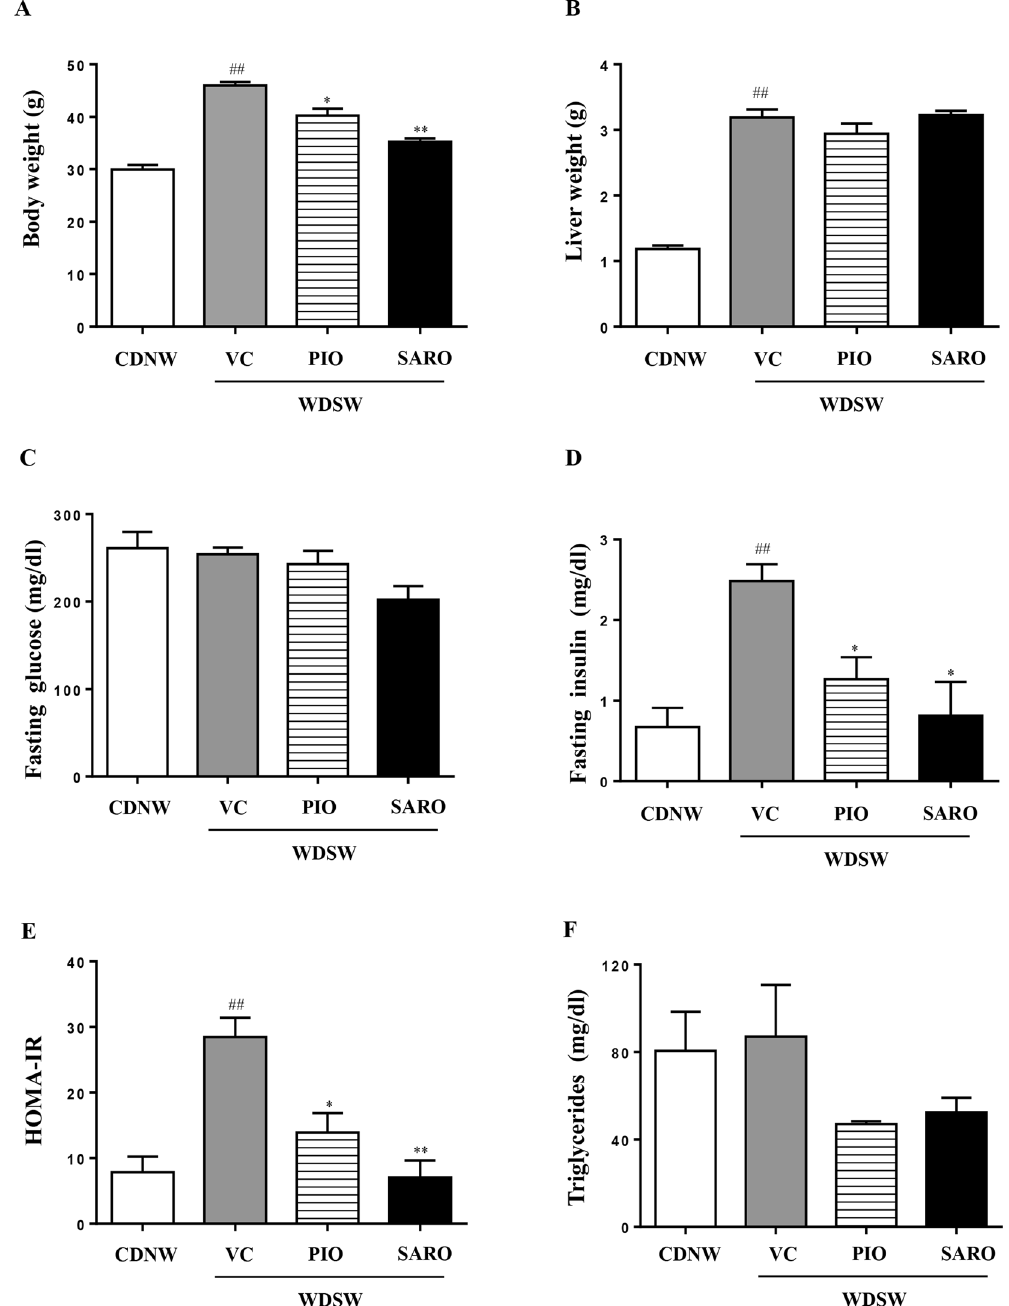
Figure 1. Preventive effect of saroglitazar on diet-induced obesity in DIAMOND mice. DIAMOND mice (B6/129 mice) were fed chow diet (CDNW) or high fructose/glucose, high fat western diet (WDSW) for up to 12 weeks to develop fatty liver and steatohepatitis. Mice were administered pioglitazone, saroglitazar or vehicle control along with CDNW or WDSW for an additional 12 weeks. ( A ) Body weight, ( B ) liver weight, ( C ) fasting glucose, ( D ) fasting insulin, ( E ) HOMA-IR, ( F ) serum triglycerides. Data are expressed as the mean ± SEM for 6–12 mice per group. ## p < 0.001 compared to CDNW; * p < 0.05, ** p < 0.001 compared to WDSW, vehicle